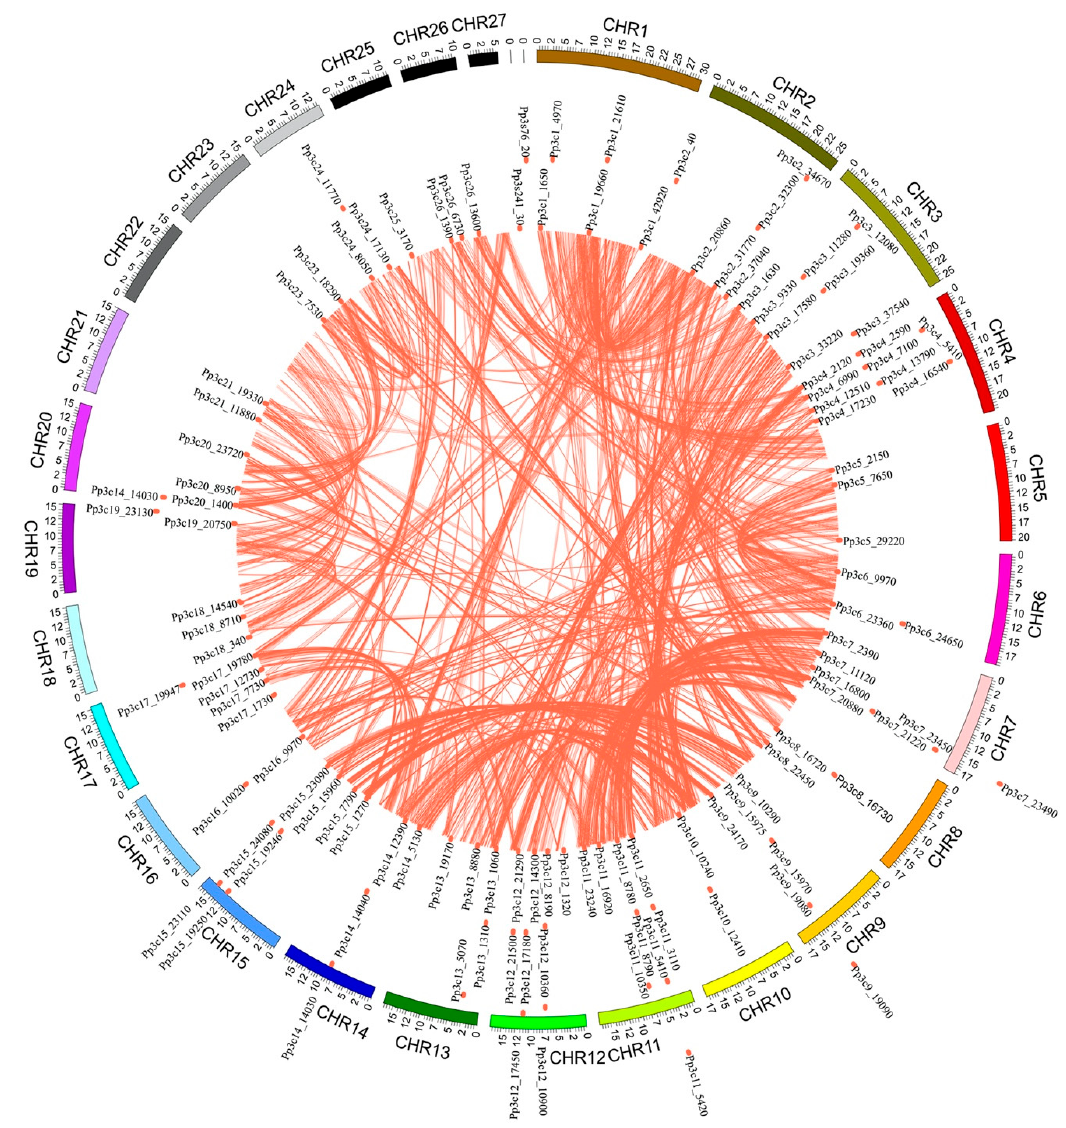
Figure 3. Chromosomal locations of MYB genes in the Physcomitrella patens genome. The P. patens chromosomes 1–27 are depicted in a circle with different colors. The terracotta bullets in front of the MYB genes indicate the position of MYB on the chromosome.